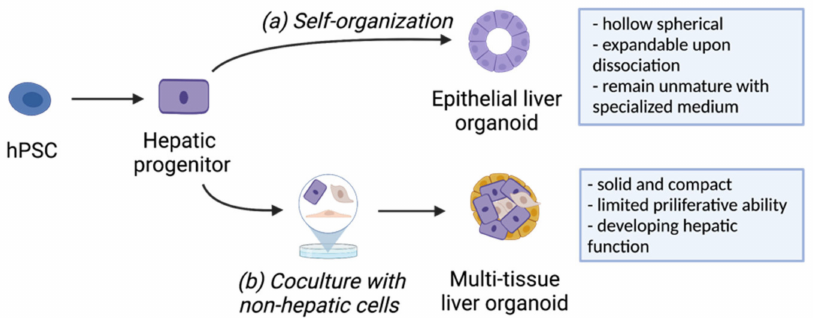
Figure 2. Generation and characteristics of ( a ) epithelial liver organoids and ( b ) multi-tissue liver organoids from hPSCs. This figure was created with